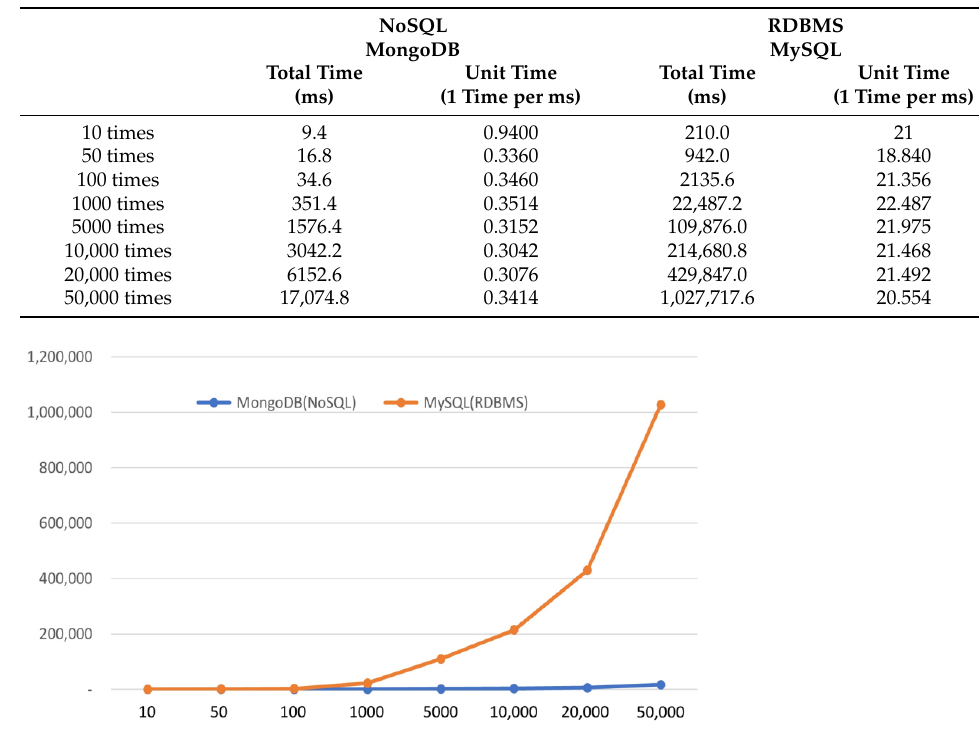
Table 1. Results of write experiment.